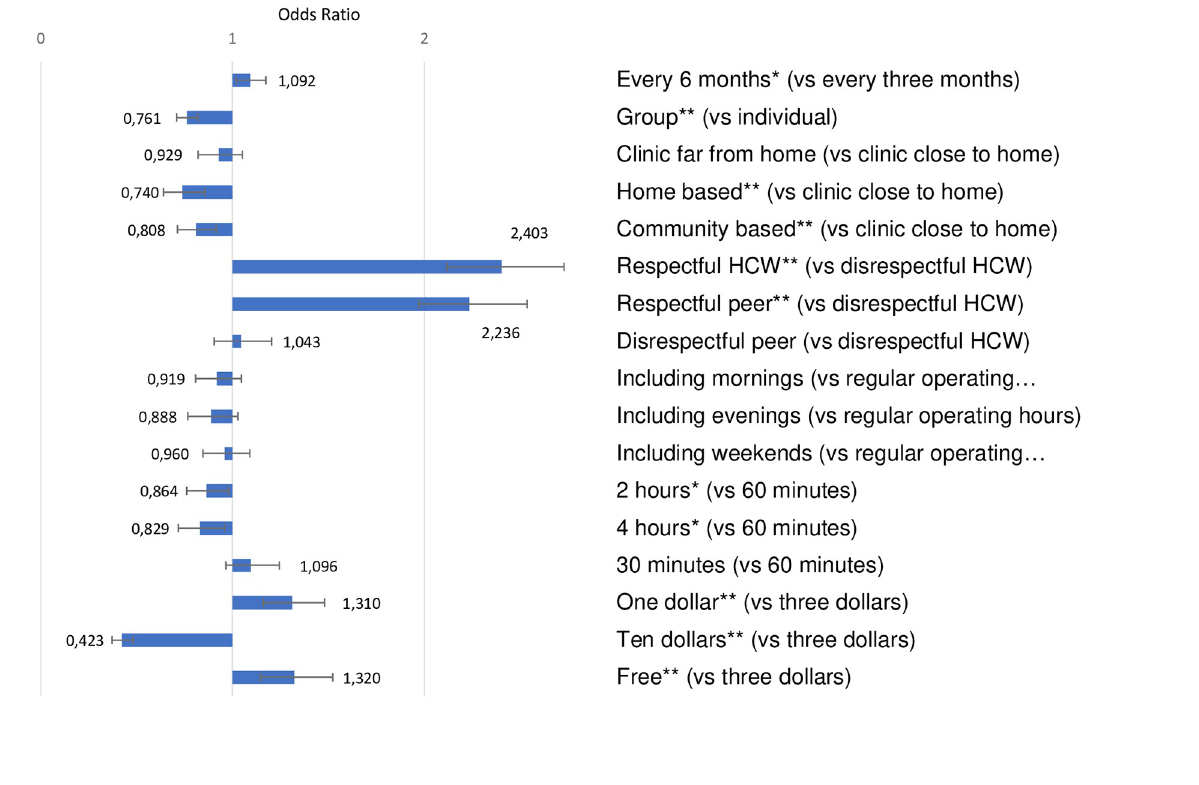
Fig 3. Discrete choice experiment